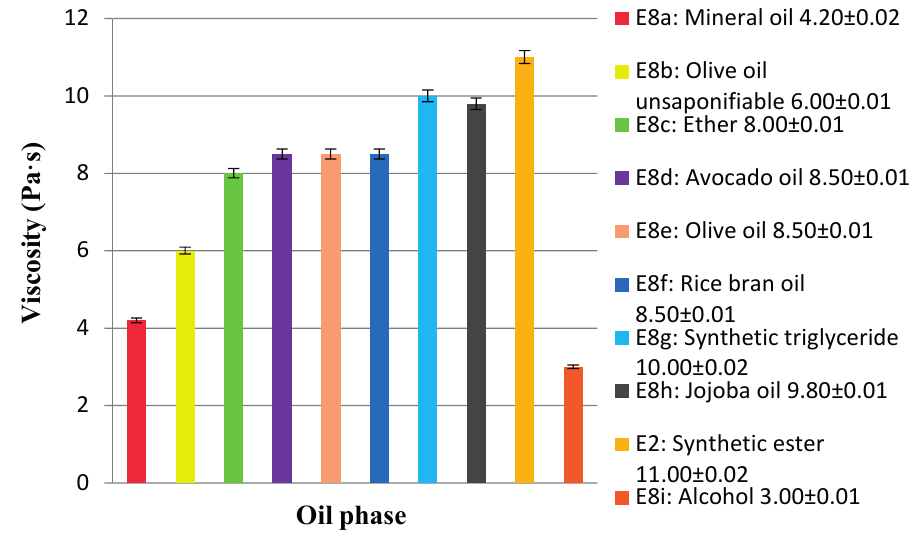
Figure 6. Viscosity of O/W basic emulsions (E2, E8a–i) prepared with oils of different polarity. The emulsions are reported according to the increasing polarity of the oil